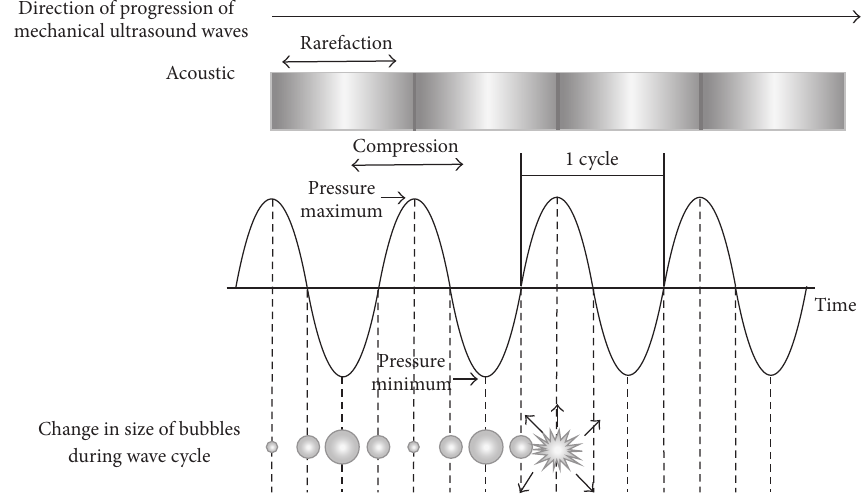
Figure 2: Ultrasonic cavitation [46].